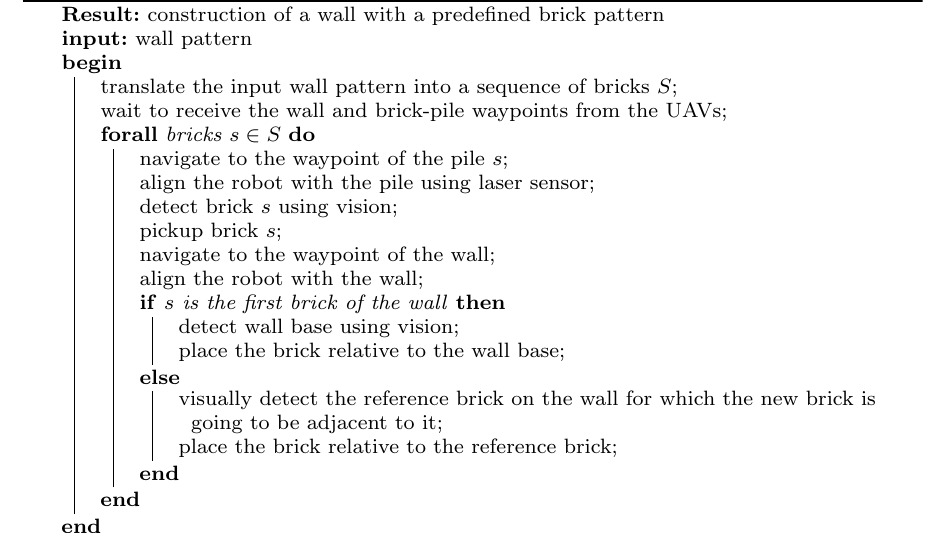
Result:Algorithm 1: Challenge 2 routine